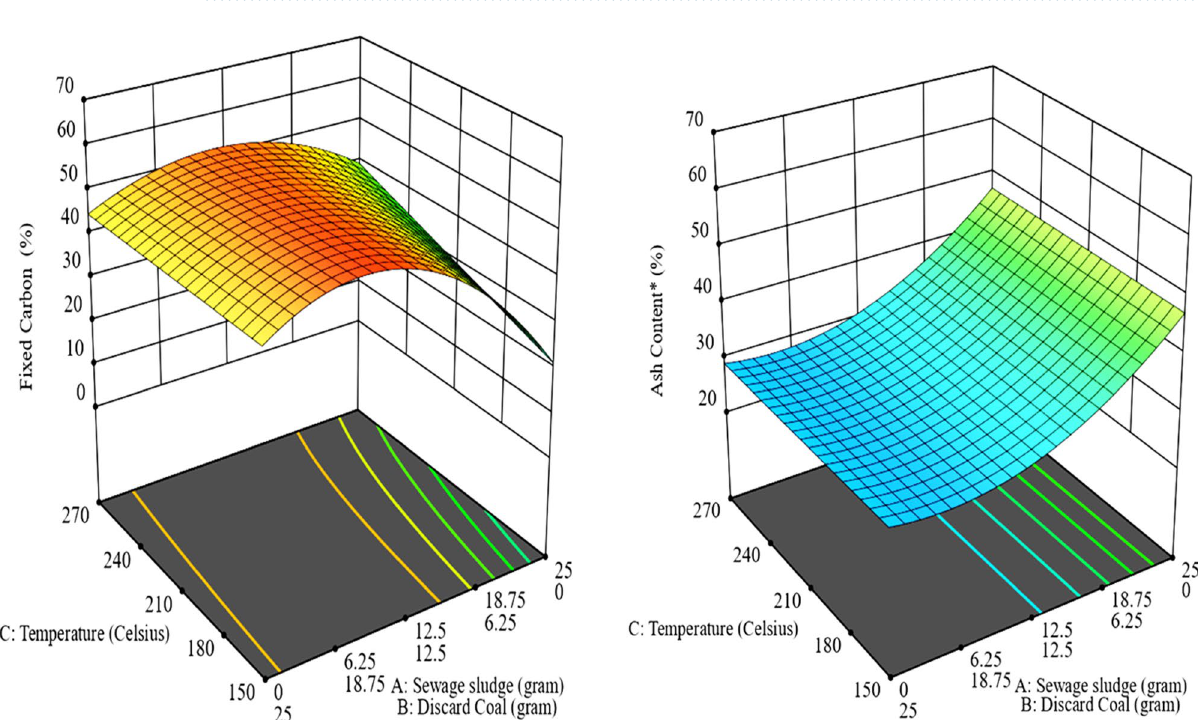
Figure 7. Surface plot showing the influence of temperature and pressure on fixed carbon (left) and Ash content (right) of the mixture of Sewage sludge and